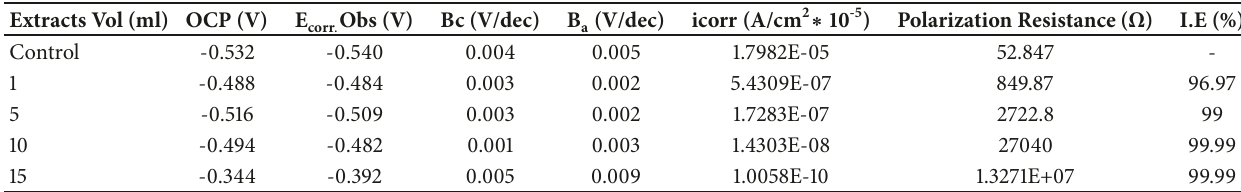
Table 5: Electrochemical parameters obtained from the Tafel plots for cathodic protection and different volumes (ml) of oil extract of Monodora myristica for steel with zinc in 0.1M sulphuric